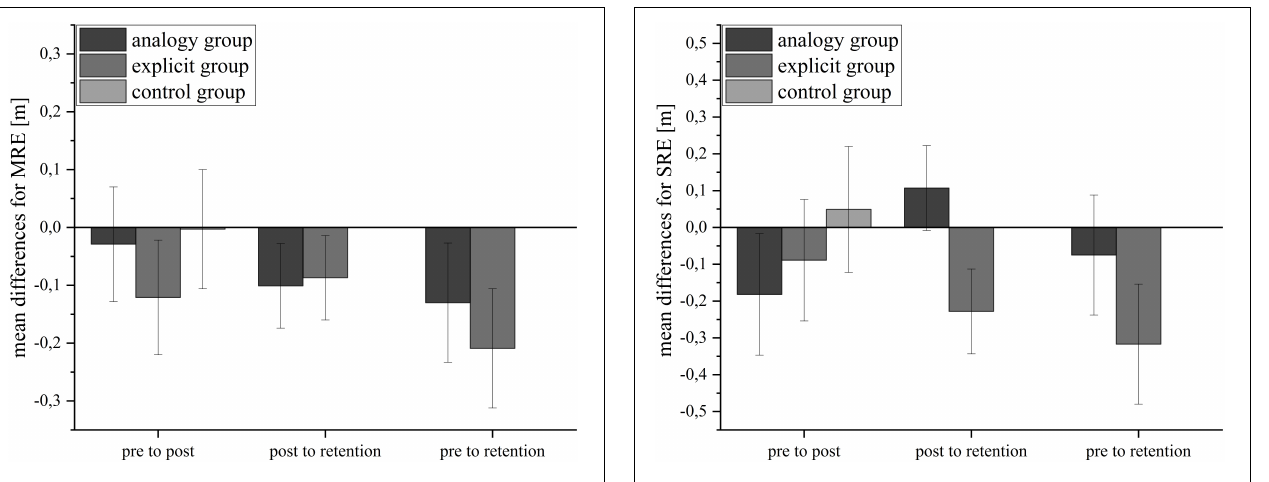
FIGURE 2 | Mean differences for subject-centroid radial error (SRE) in meters for the three groups from pretest to posttest, posttest to retention test, and from pretest to retention test. Error bars represent standard errors.